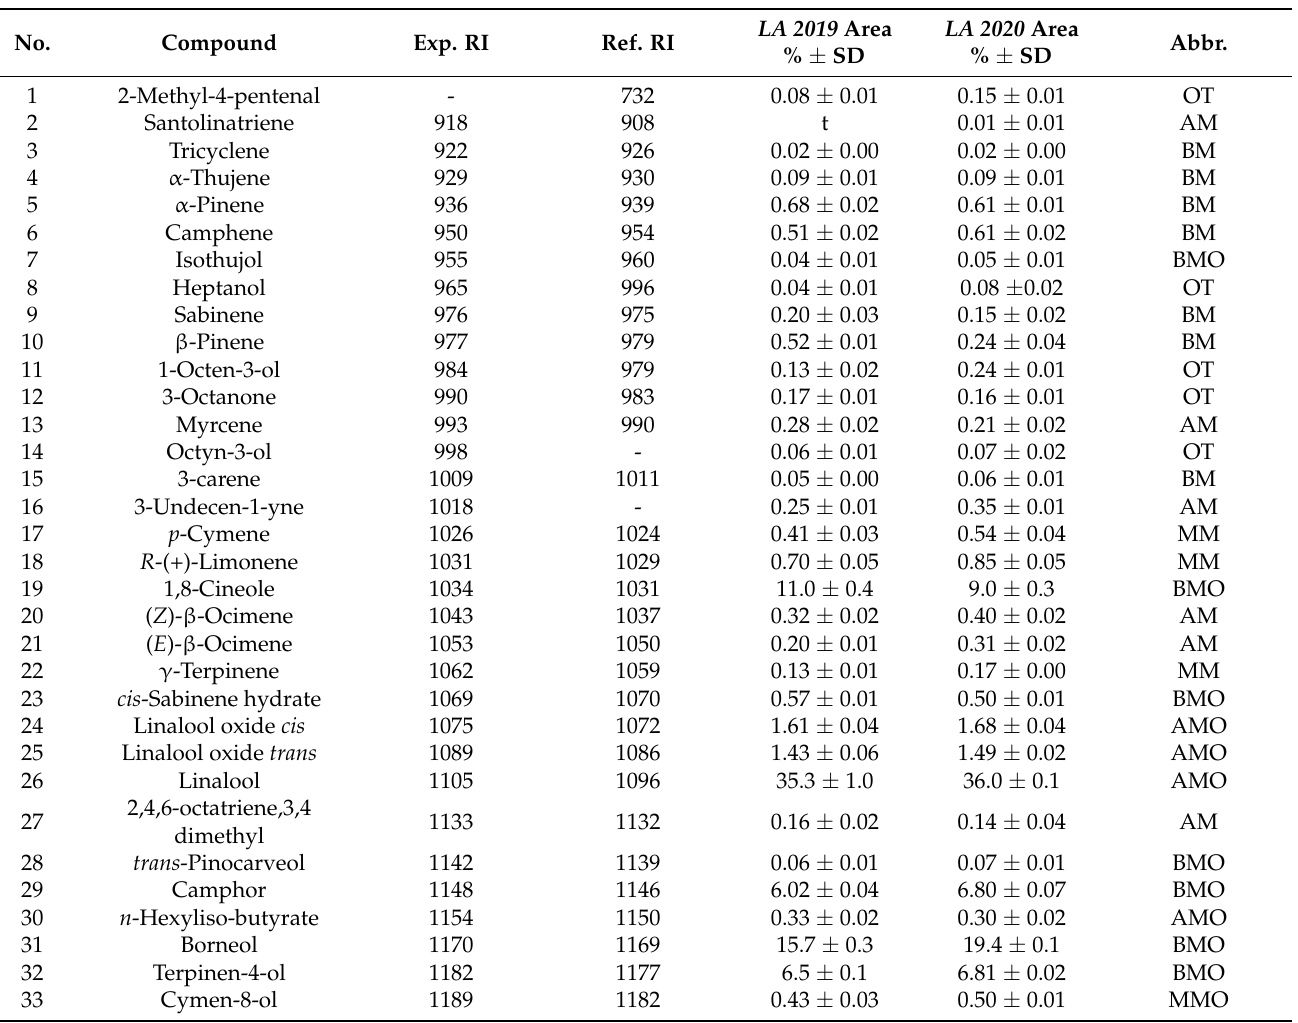
Table 1. Chemical composition of the essential oils (EOs) extracted from the flowers of L. angustifolia . No. Compound Exp. RI Ref.